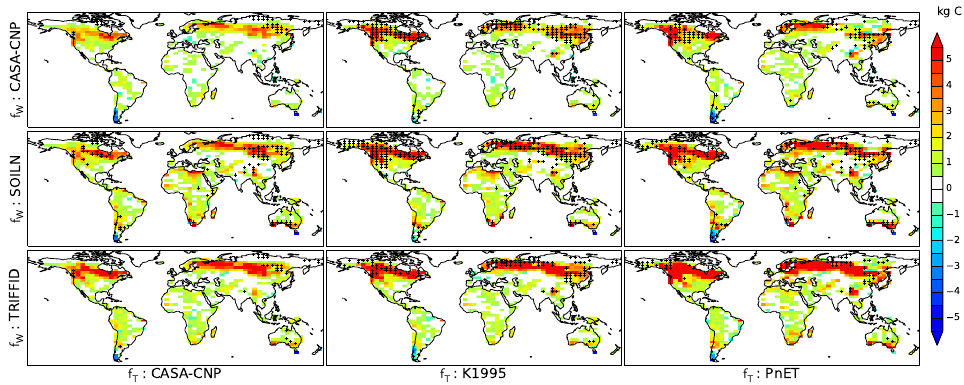
Fig. 8. Difference in cumulative NEA between C-only and CN historical simulations for the same combination of f W and f T . Stippling represent areas where the sign of cumulative NEA is different between C-only and CN